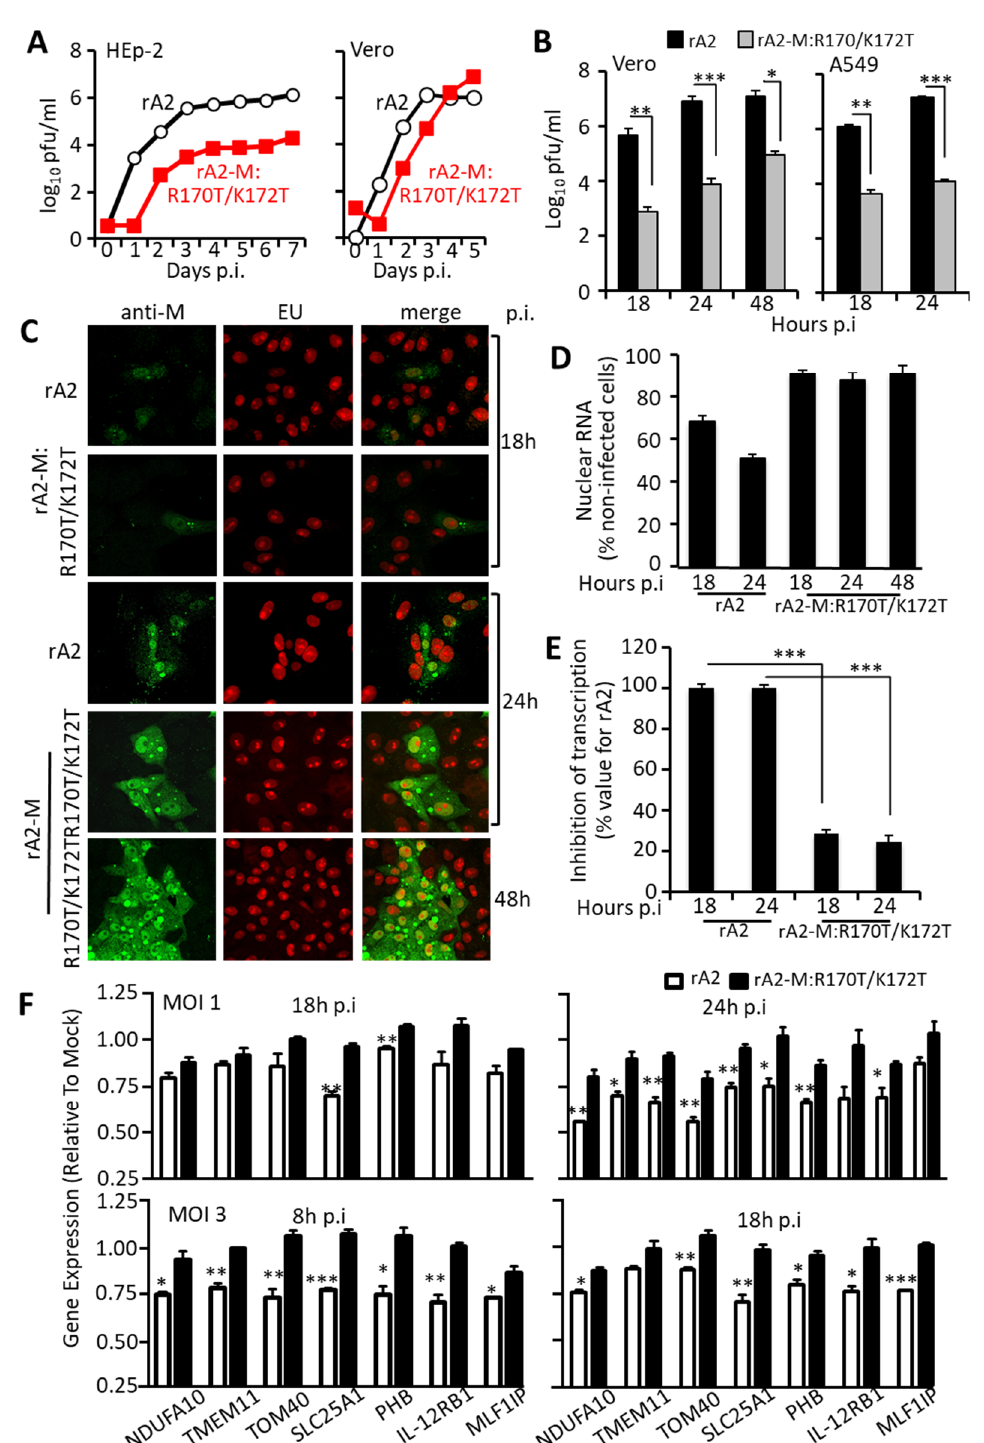
Figure 6. Recombinant RSV carrying R170T/K172T mutations in M shows impaired virus production and transcriptional inhibition. ( A ) HEp-2 (left) or Vero (right) cells were infected with recombinant wild type (rA2, open circles) or mutant (rA2-M:R170T/K172T, filled squares) virus at an MOI of 0.01, and samples collected every day for 7 (HEp-2) or 5 (Vero) days and virus titre estimated using immunostaining plaque assay. Results represent the mean +/ − SEM ( n = 3) for log plaque forming units (pfu)/mL. ( B ) Vero or A549 cells were infected with wild type rA2 (black columns) or mutant (rA2-M:R170T/K172T, grey columns) at an MOI of 3. Cells were harvested at the indicated times p.i. and analyzed for cell-associated infectious virus by plaque assays. Results represent the mean +/− SEM ( n = 3) for log pfu/mL. * p < 0.05, ** p < 0.01, *** p < 0.001. ( C ) Vero cells were infected with rA2 or rA2-M:R170T/K172T at an MOI of 3 followed by incubation